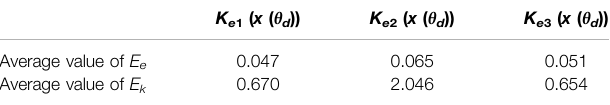
TABLE 4 | Evaluation function of the end-point position and joint stiffness vector. TABLE5|